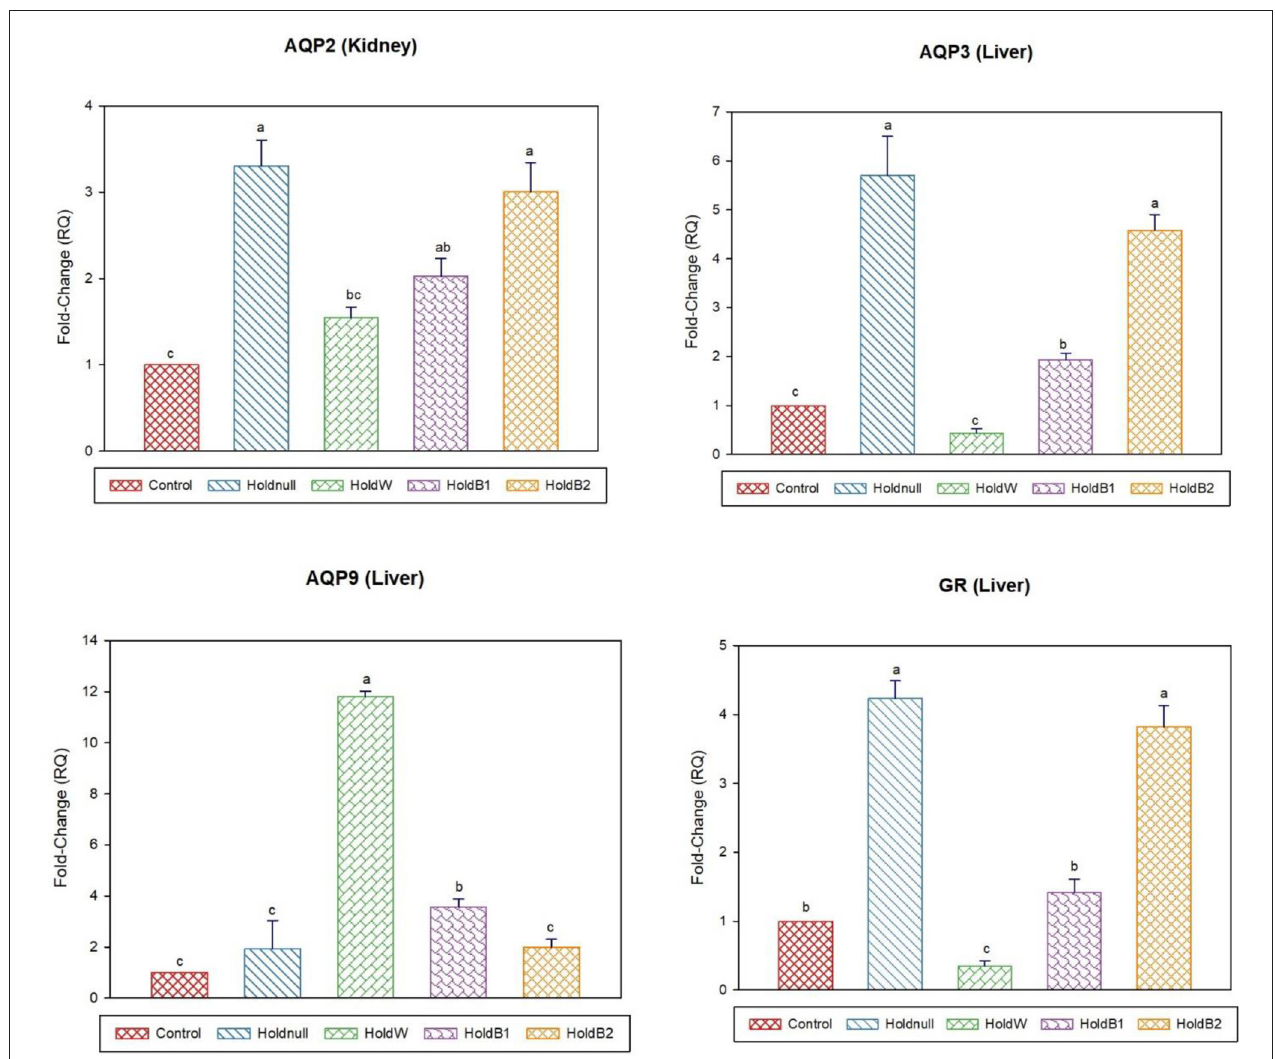
FIGURE 2 | Effect of betaine on the relative expression (fold-change or RQ) of AQP3 , AQP9, GR in the liver, and AQP2 in the kidney of day-2 old chicks. Control, placed on feed immediately; Holdnull, holding for 48h + no access to feed or water; HoldW, holding for 48h + water only; HoldB1, holding for 48h + water supplemented with betaine (1ml per L); HoldB2, holding for 48h + water supplemented with betaine (2ml per L). Bars with different letters are significantly different ( p < 0.05). Mean ± standard error of the mean, n = 6. AQP, aquaporin; GR, glucocorticoids